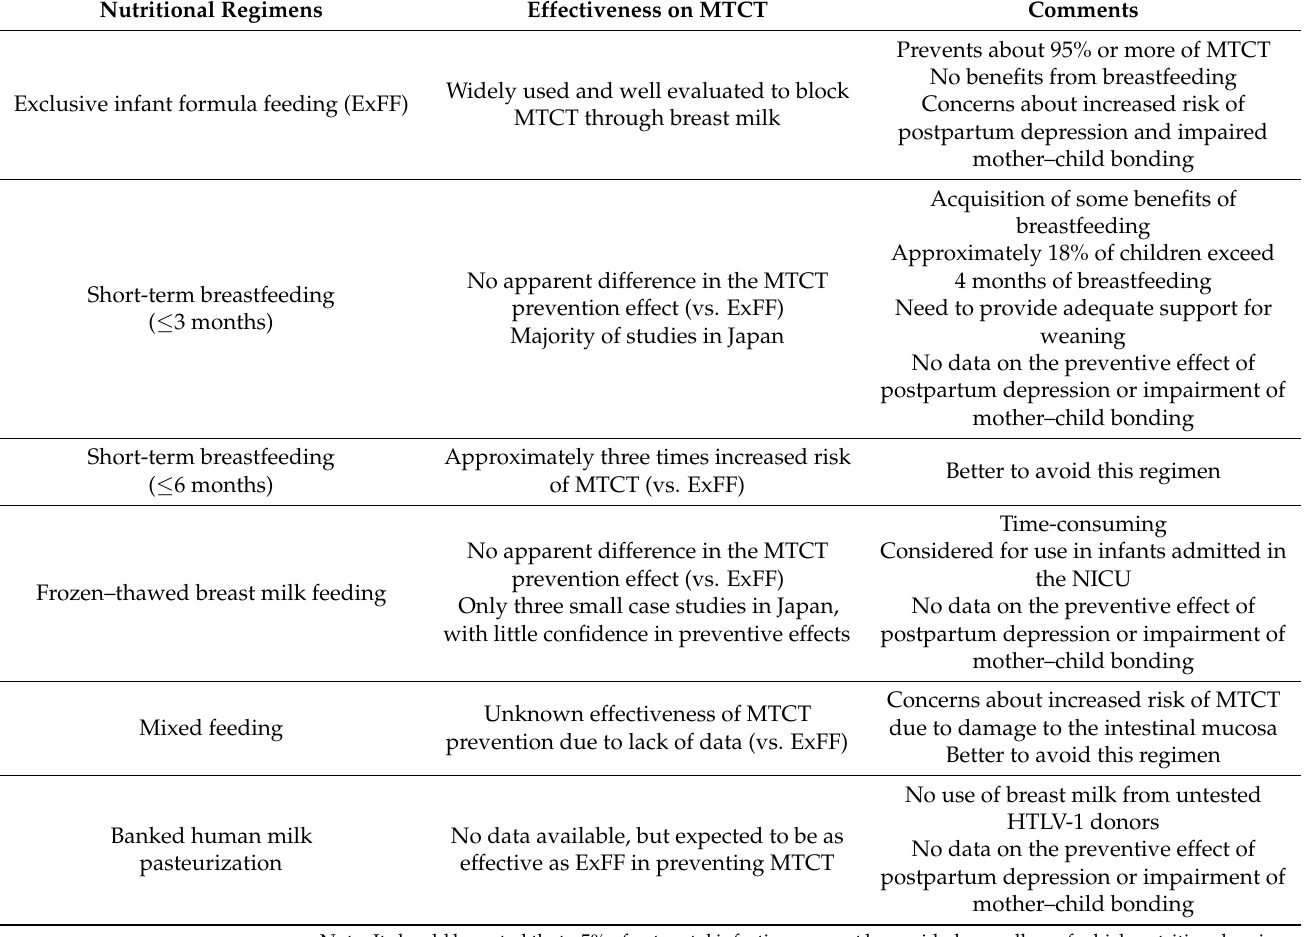
Table 1. Effectiveness of feeding regimens in peventing mother-to-child transmission and their